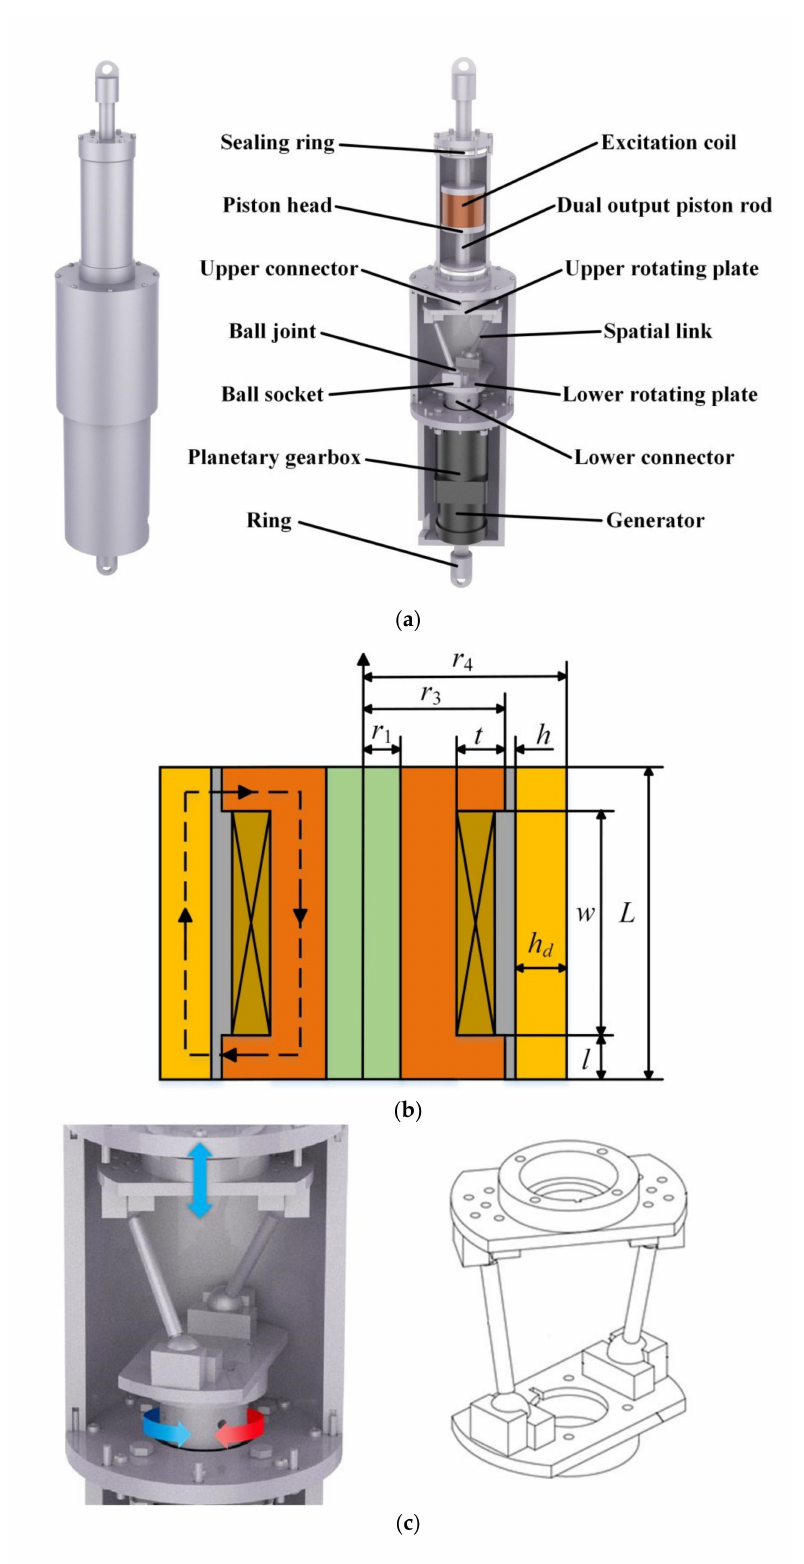
Figure 1. Structural diagram of the proposed self-powered MR damper. ( a ) Three-dimensional view of a self-powered MR damper. ( b ) Structural parameters of the self-powered MR damper. ( c ) Working-principle diagram of the transmission component of the